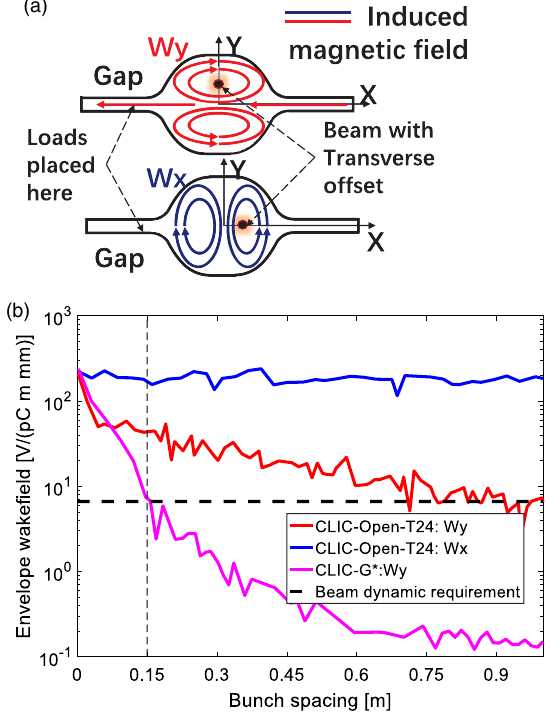
FIG. 3. Wakefield suppression of CLIC-T24-Open: (a) philoso- phy; (b) time-domain wakefield potential (CLIC-G* is the baseline main linac accelerating structure design).